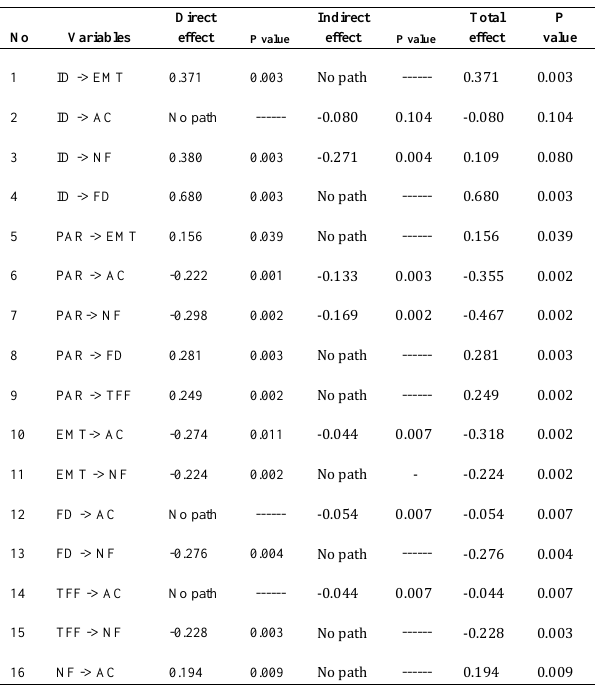
Table 5. Total Effects of ID and Parallax on Eye Move- ment